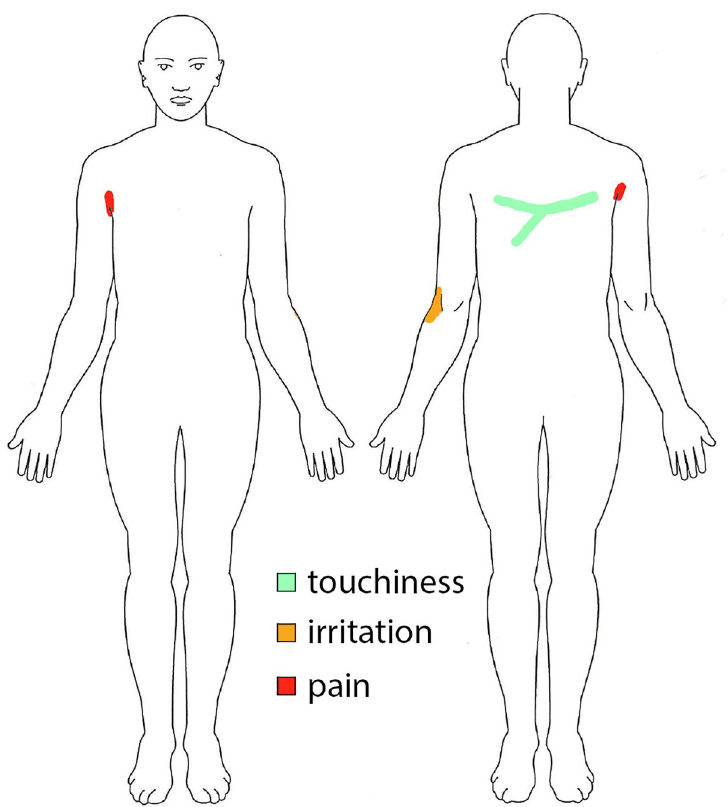
Fig 2. Body-map. The Body-Map was coloured by one subject indicating pain (red) at the back of the left elbow, irritation (orange) in the right arm pit and touchiness (green) on a stripe of his back.